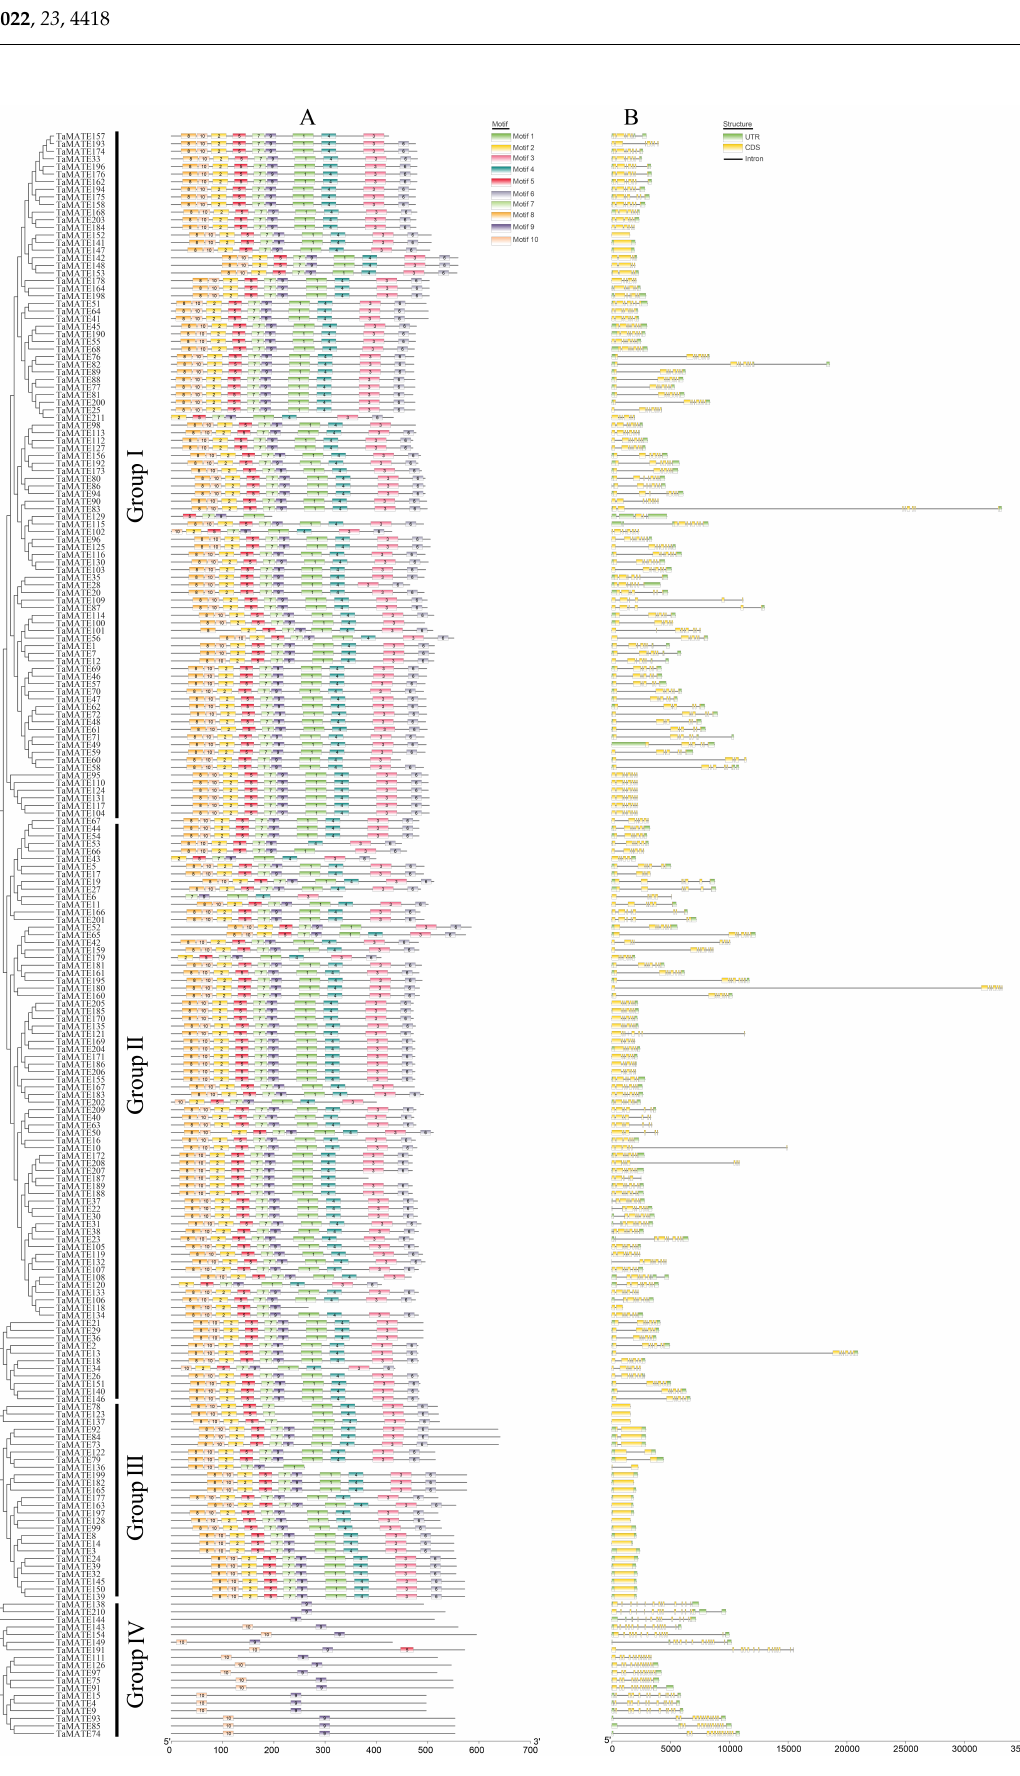
Figure 2. The motif and exon-intron organisation of MATE gene family members in wheat. ( A )